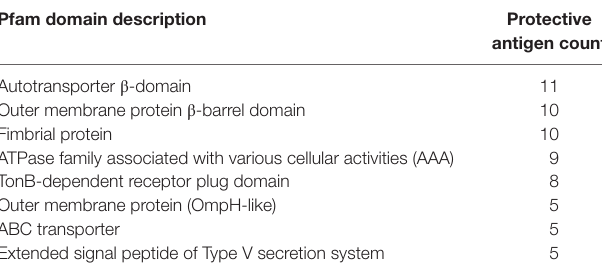
TaBle 1 | Frequent Pfam-A conserved domains among reported PAgs.